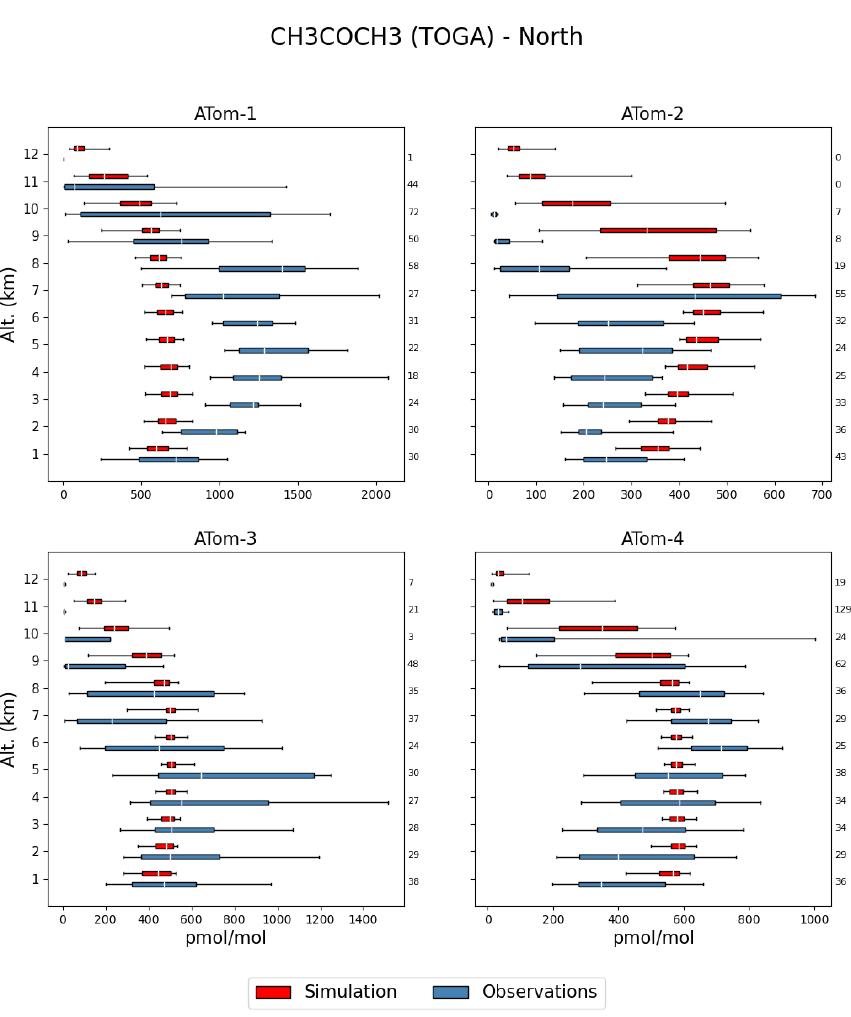
Figure 10. The same as Fig. 9 but for CH 3 COCH 3 and for the region over Canada, Alaska and Greenland (region 7 in Fig. 2) for the different ATom campaigns and seasons.